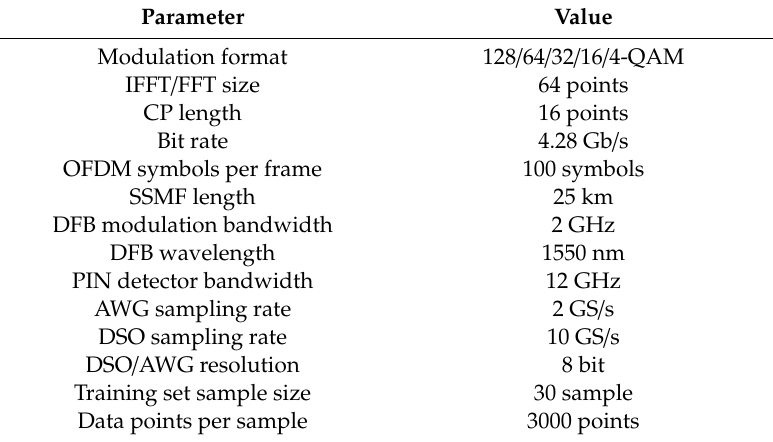
Figure 2. The experimental setup of intensity modulation and direct detection (IMDD) orthogonal frequency division multiplexing (OFDM) system. Table 1. Transceiver and system